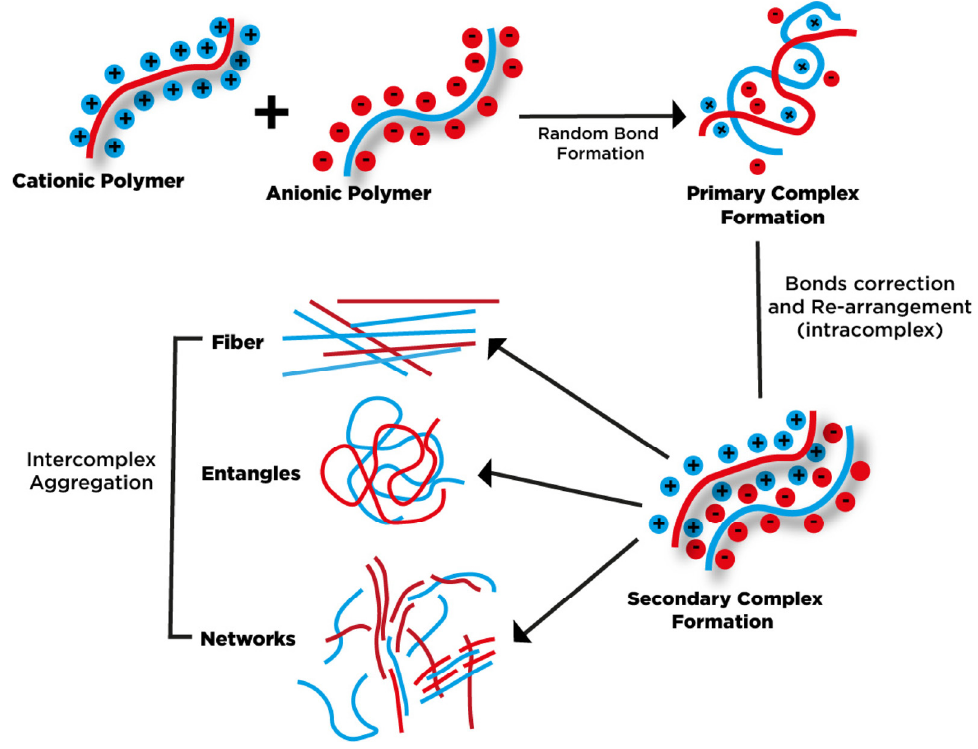
Figure 4. Illustration of the formation of polyelectrolyte complex. Reproduced from